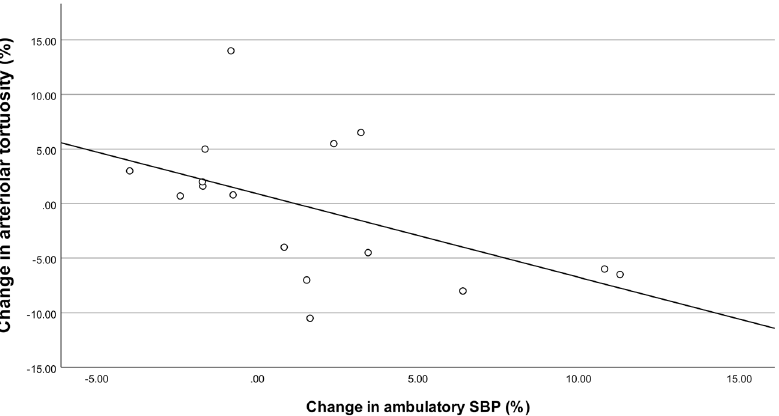
Figure 3. Scatterplot of the correlation between change in arteriolar tortuosity and change in ambulatory SBP. Changes were calculated as the values of (high-salt diet − low-salt diet)/(low-salt diet)* 100. There was a significant correlation between arteriolar tortuosity and the ambulatory SBP (r = − 0.513; p = 0.042). SBP, systolic blood